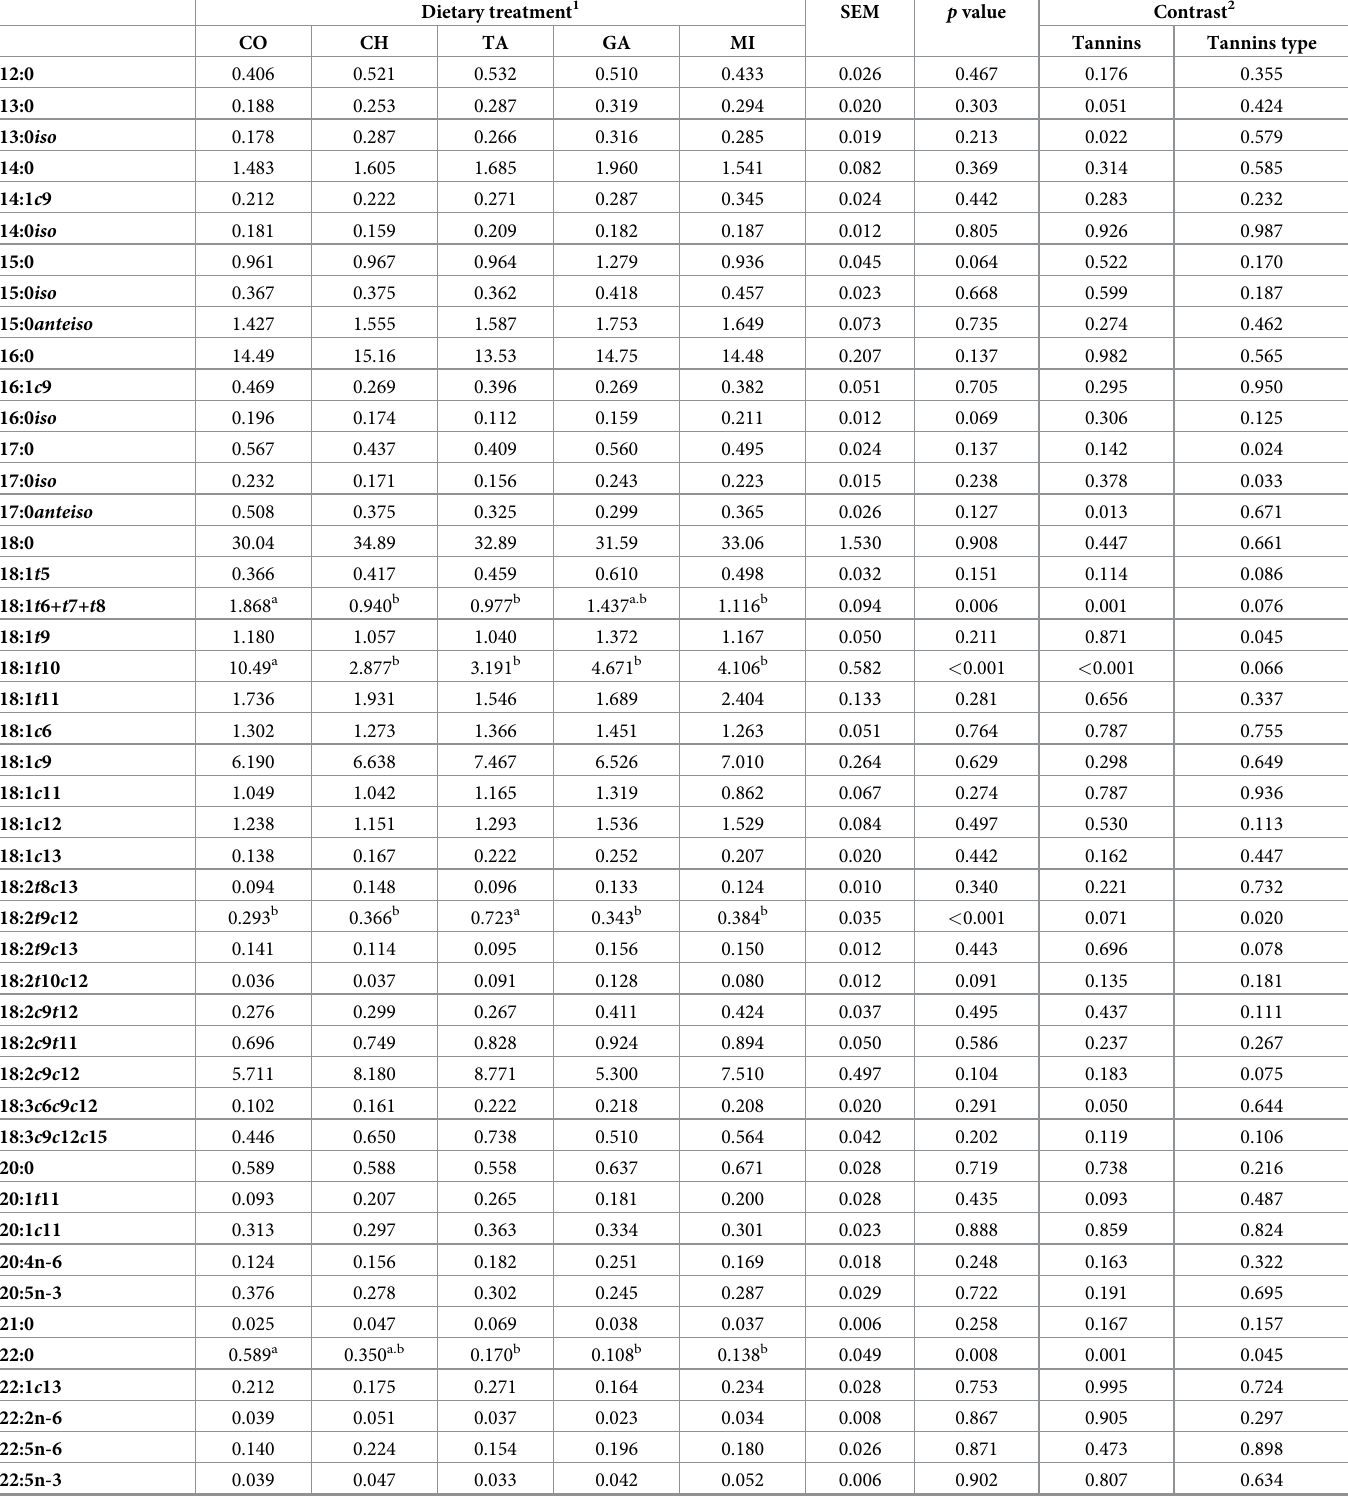
Table 3. Effect of different tannin extracts on the fatty acid composition of rumen content (g/100g total fatty acids).